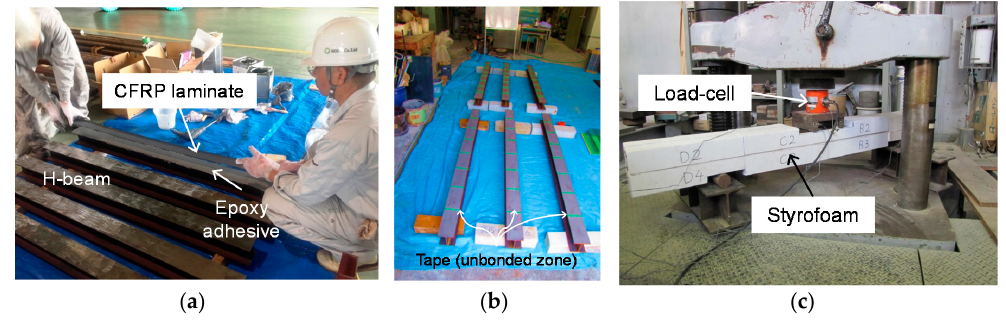
Figure 2. Specimen preparation and test setup: ( a ) CFRP bonding; ( b ) creation of the periodic unbonded zone along the beam; ( c ) flexural test.